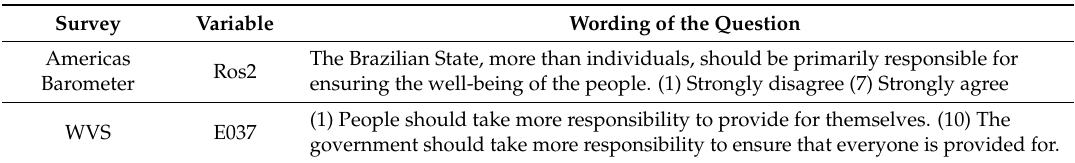
Table 1. Questions related to social support for the